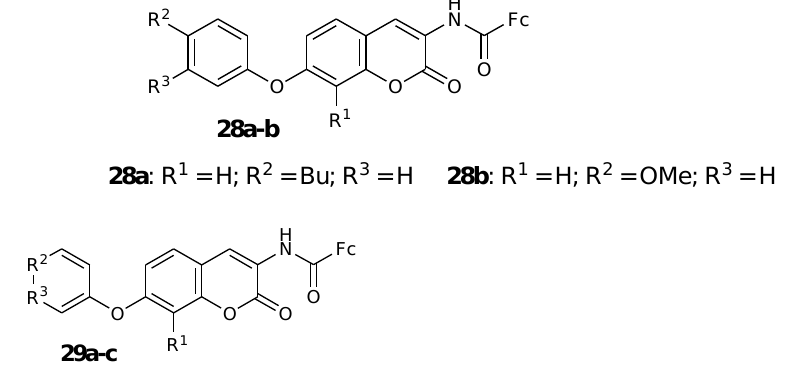
Figure 11. Ferrocenyl – novobiocin derivatives ( 28a – b and 29a – c ).